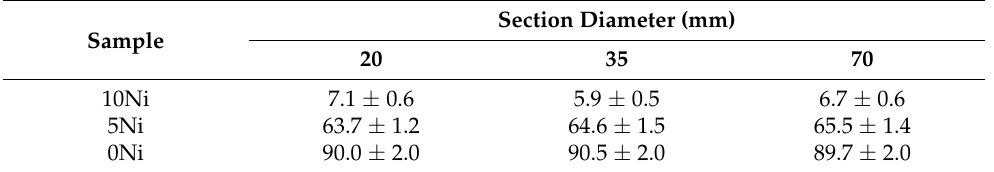
Table 10. Ferrite fraction in steel samples (%).